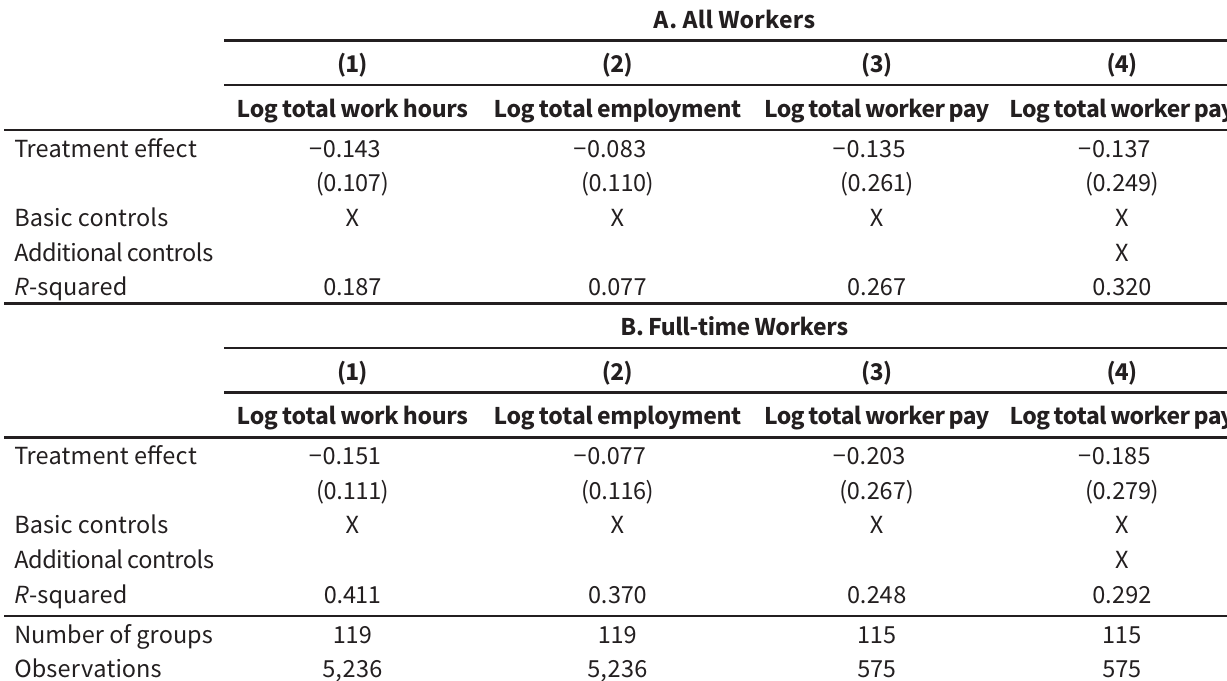
Group-level estimation